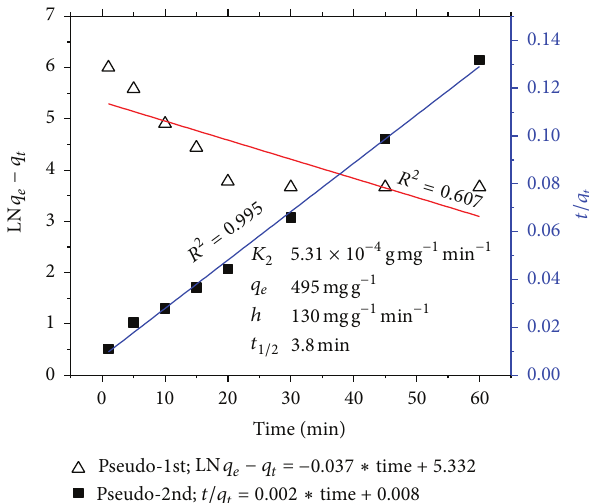
Figure 7: N 2 adsorption-desorption isotherms of MMT, UMMT, and RMMT.